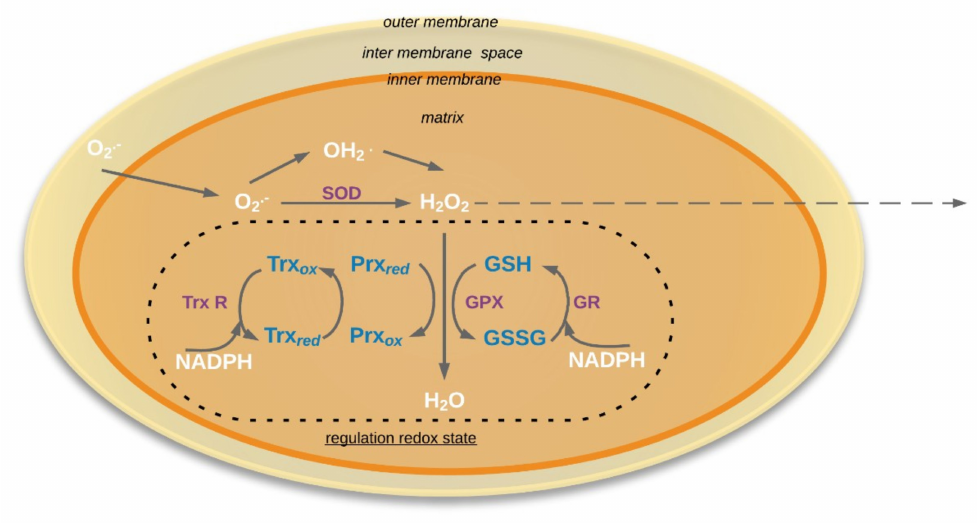
Figure 2. Schema of regulation redox state in the mitochondria. O 2 •− : Superoxide; HO 2 · : Hydroperoxyl radical; SOD: Superoxide dismutase (E.C. 1.15.1.1); GR: Glutathione reductase (EC 1.6.4.2); GSH: reduced form glutathione; GSSG: oxidized form glutathione; GPX: glutathione peroxidases (EC 1.11.1.9); Prx: peroxiredoxin; Trx: Thioredoxin; TrxR: NADPH-thioredoxin reductase (EC 1.8.1.9). Solid arrows mean that process occurred in mitochondria, dotted arrows mean that molecules could be exported outside the